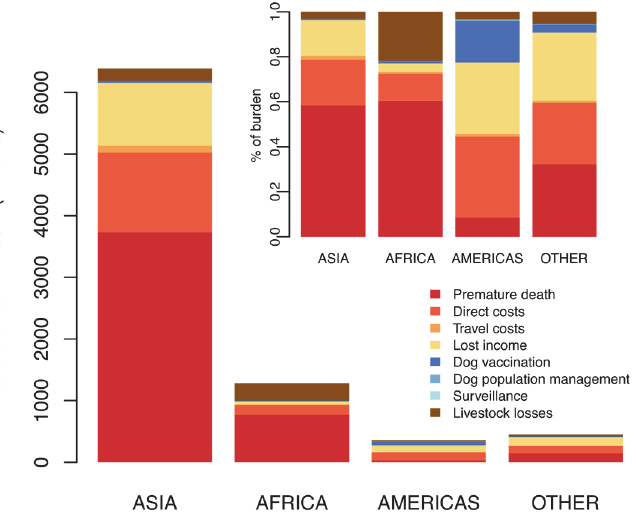
Fig 5. Division of costs associated with rabies, prevention and control across sectors by region. Inset shows proportional expenditure in different regions. The breakdown of costs by cluster is given in S1 Fig and Table 3 and detailed by country in S1